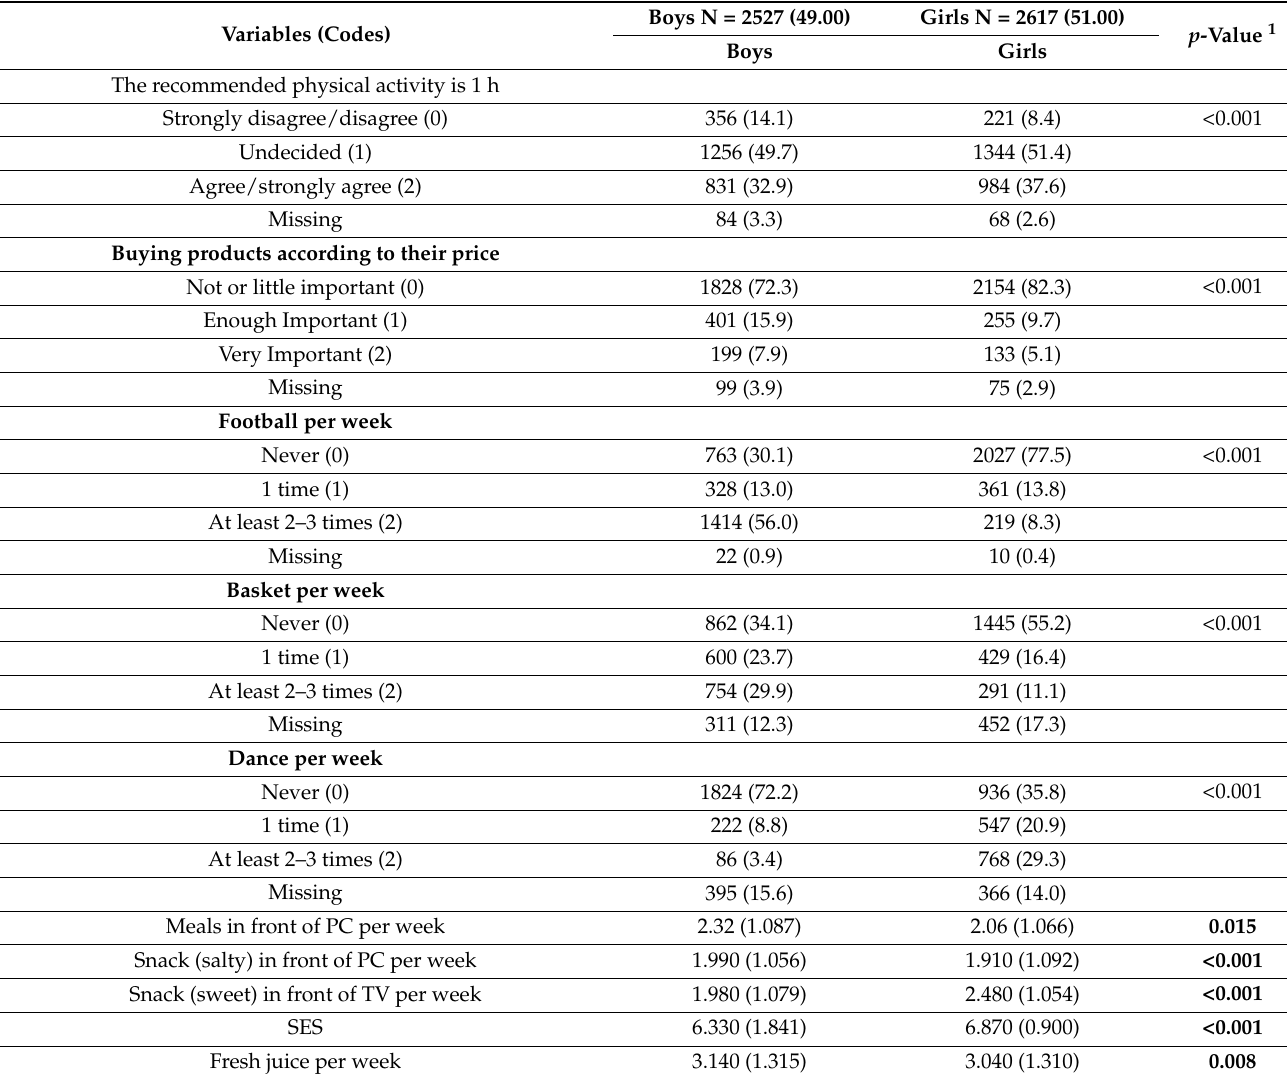
Table A4. Descriptive statistics and statistical tests ( α = 5%) by sex for no significant variables on multivariate